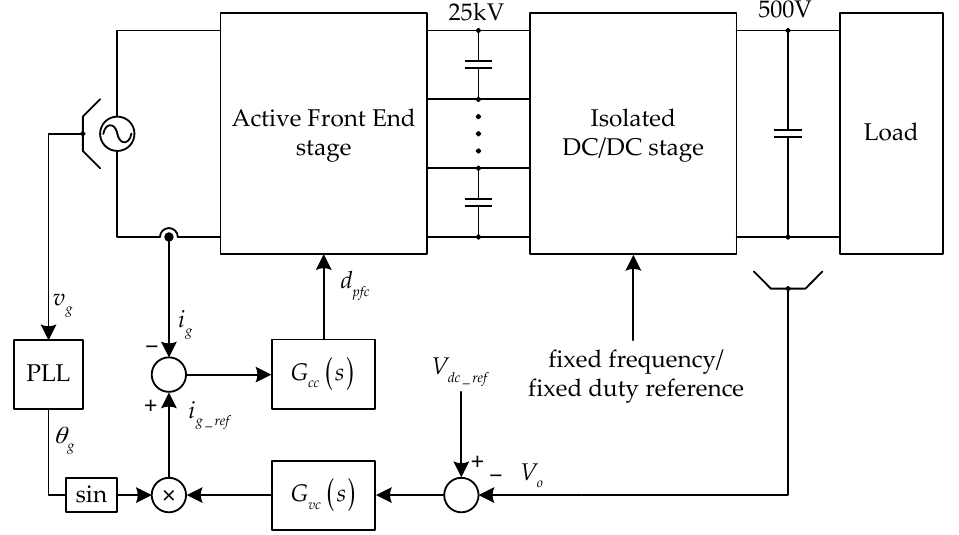
Figure 11. Control structure of the solid-state-transformer. PLL: phase-locked-loop.